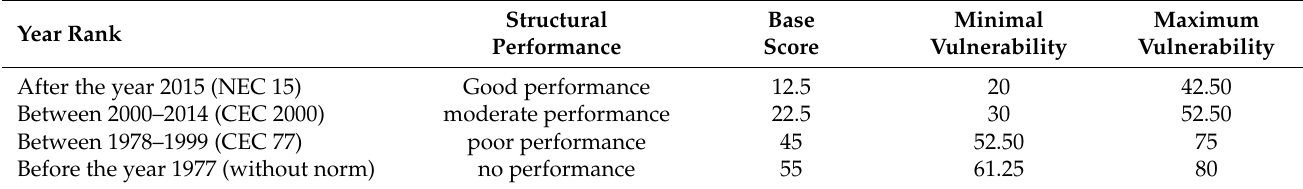
Table 3. Base scores and expected vulnerability ranges by year of